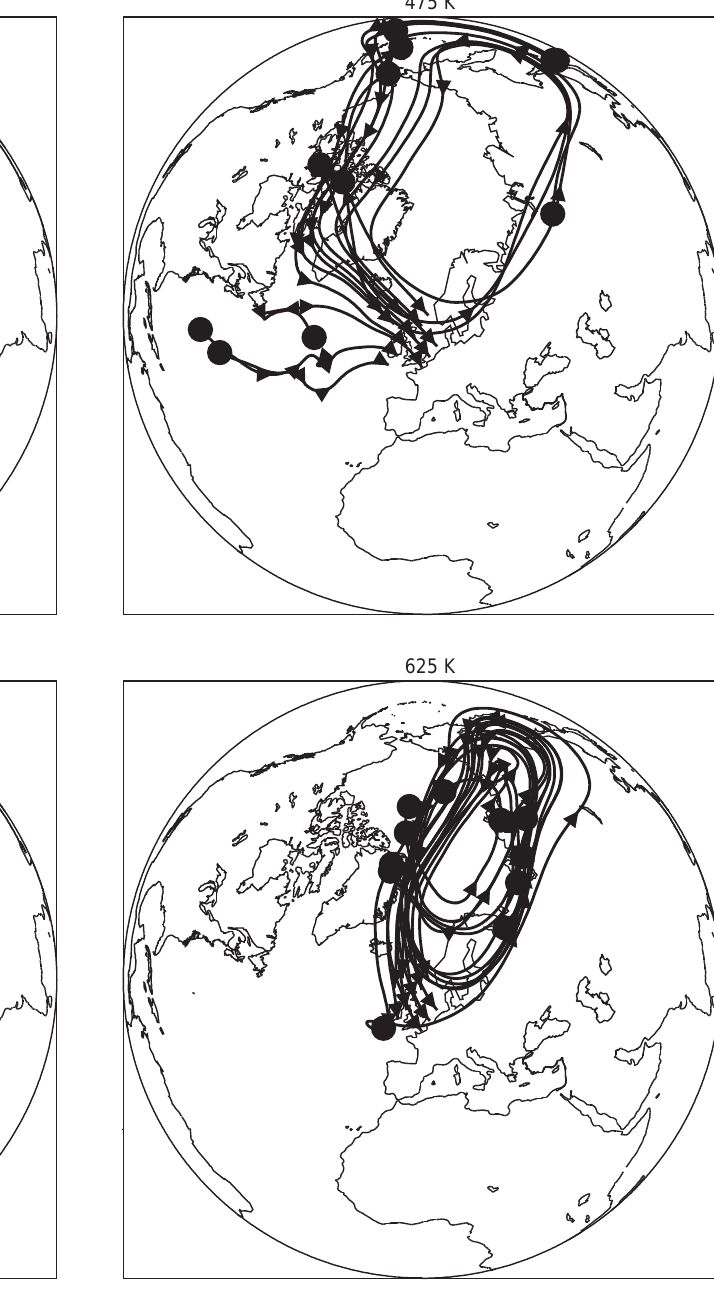
Fig. 5. 10-day air parcel trajectories calculated from analysed winds and ending on 30/4/97. Trajectories were calculated for end points at intervals of 2 (cid:14) latitude and 2.5 (cid:14) longitude but for clarity only every fourth trajectory is shown. The start points are indicated by the circles ; the arrow heads denote the direction of travel and are plotted at